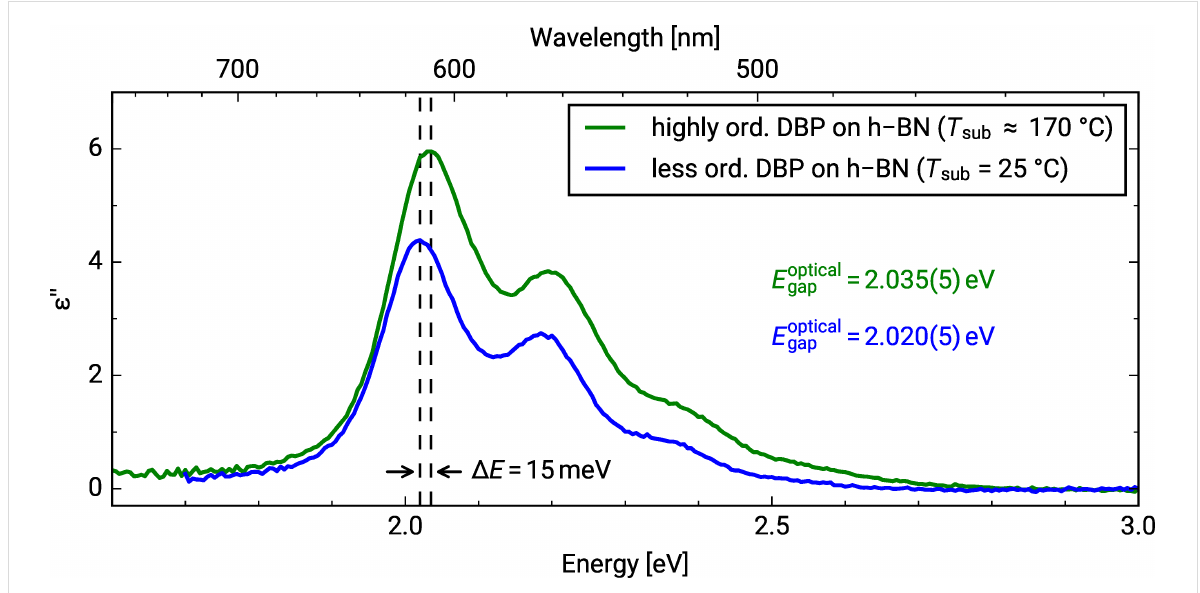
Figure 2: Imaginary part of the dielectric function obtained from the differential reflectance spectra of 1 MLE DBP on h-BN/Ni(111) (blue: substrate temperature = 25 °C, green: substrate temperature approx. 170 °C). Black dashed lines mark the spectral position of the S 0 → S 1 transition.